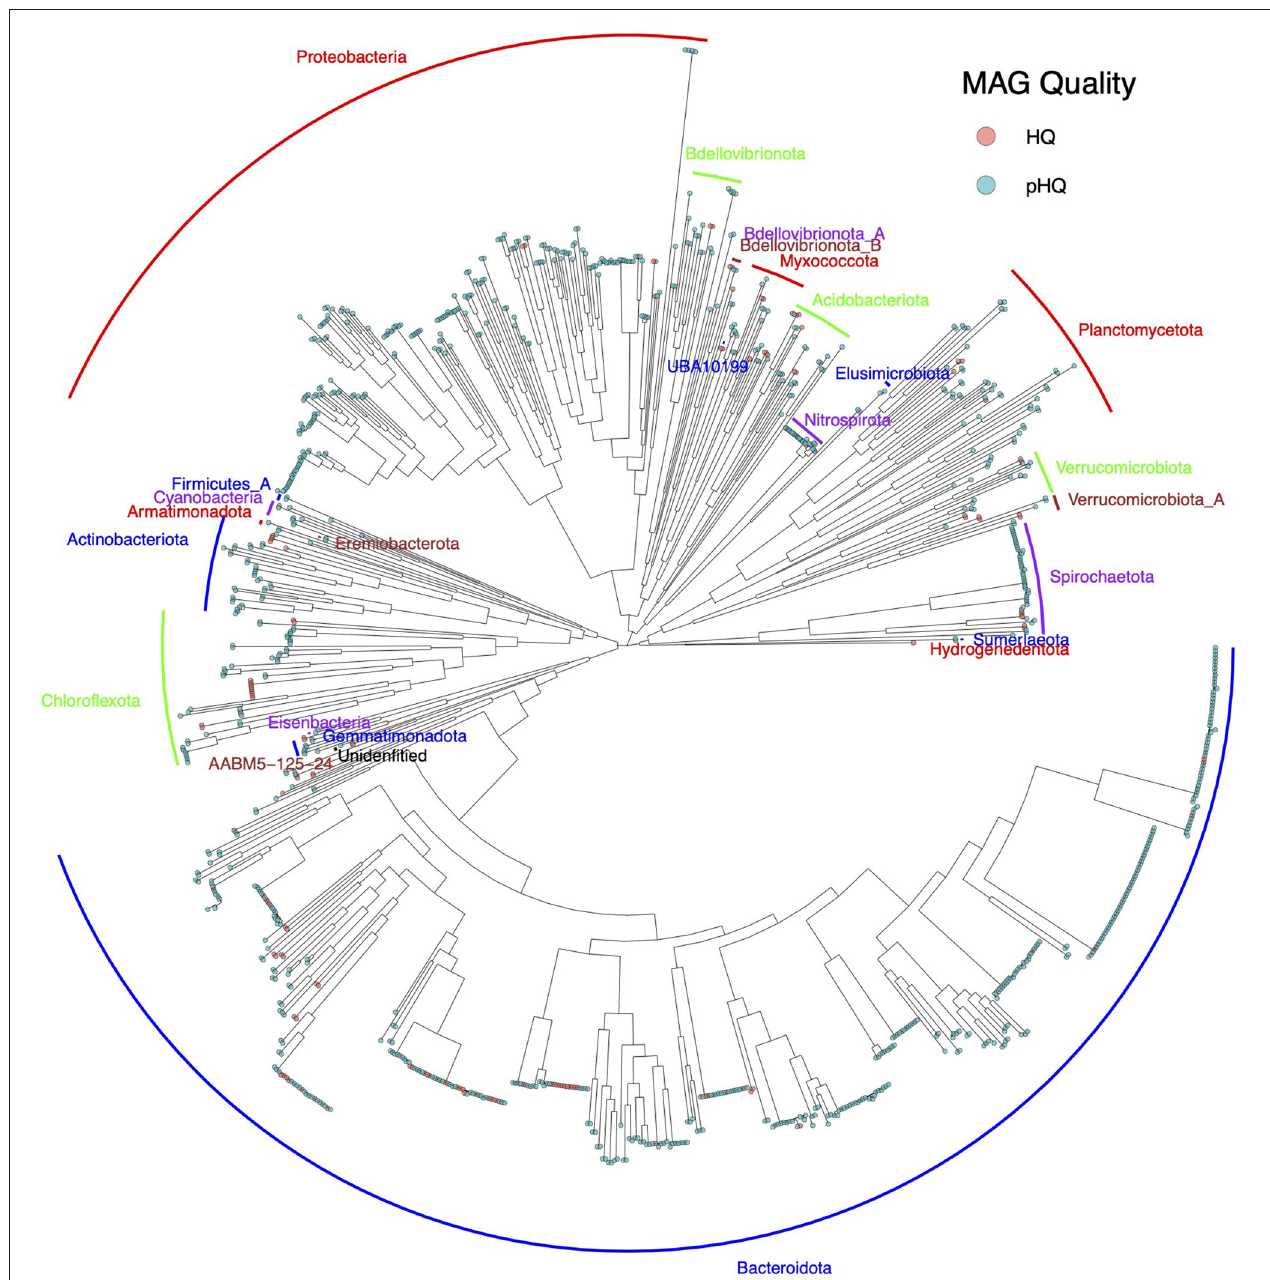
FIGURE 5 | Phylogram of pHQ MAGs recovered from all four workflows used in this study. Phylum level annotations are listed as text labels. MAG holding pHQ status are highlighted in blue-green and the subset of those that hold HQ status under the MIMAG are highlighted in light